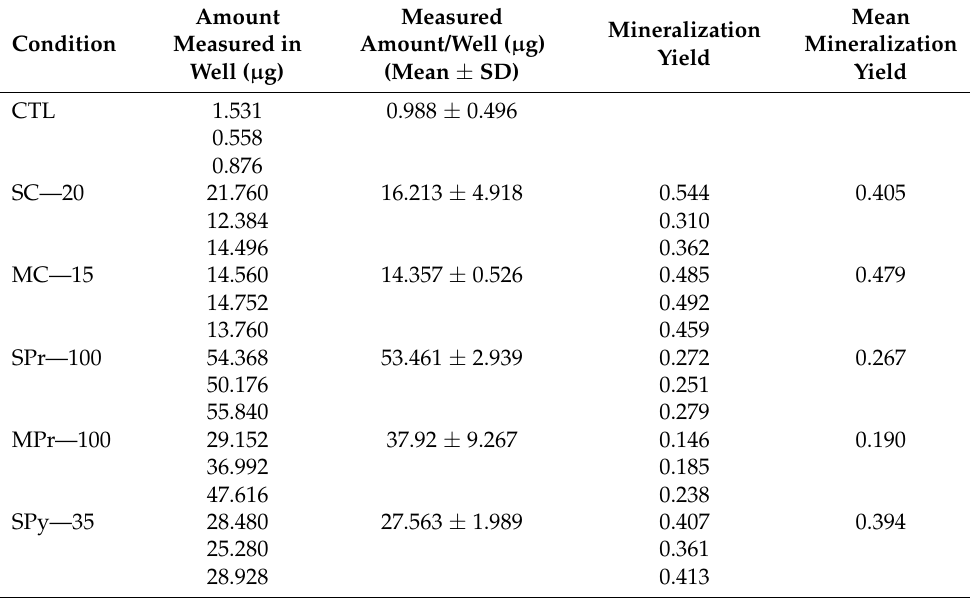
Table 1. Mineralization efficiency according to synthetic amorphous silica forms.